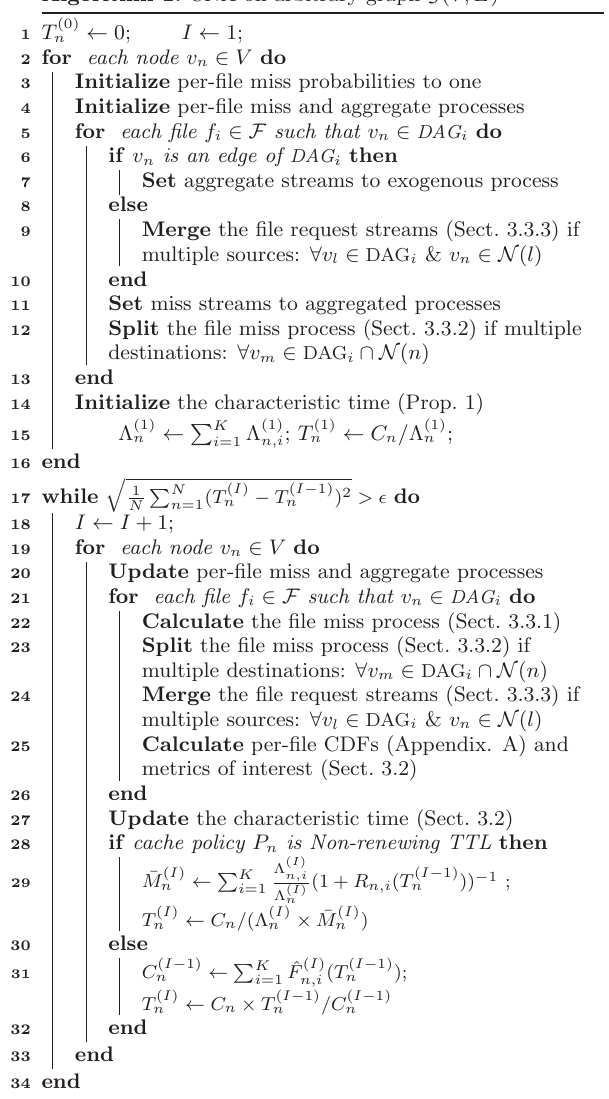
Algorithm 1: CNA on arbitrary graph G ( V,E